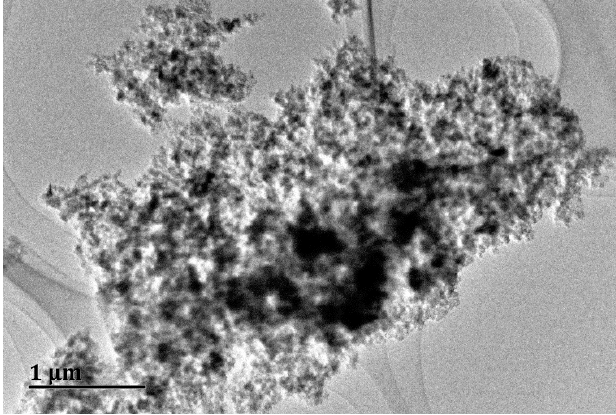
Figure 1. Transmission electron mocroscopy (TEM) image of nano-Al 2 O 3 in the exposure solution. Nano-Al 2 O 3 was agglomerated to large particles (about 1000–3000 nm).